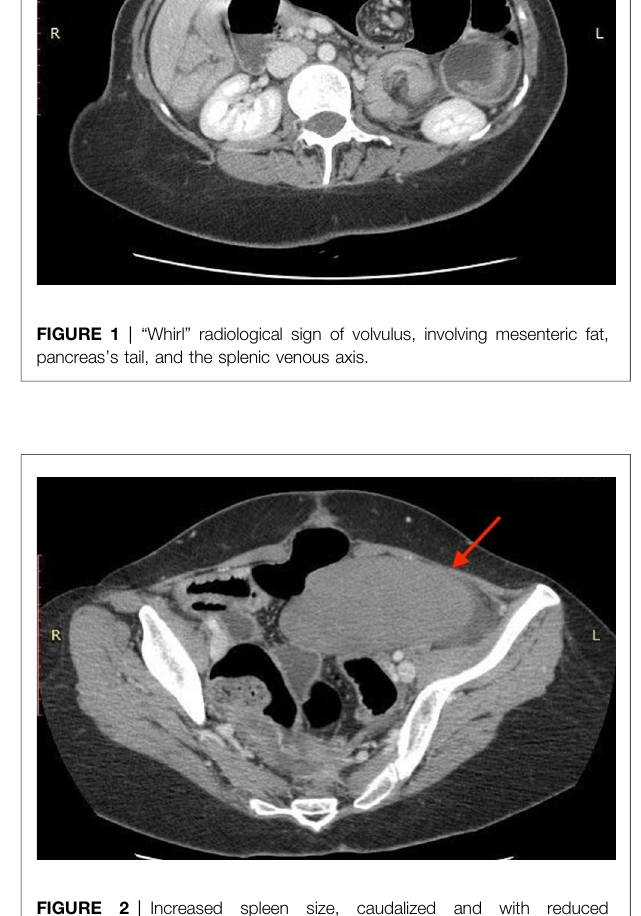
FIGURE 4 | Median sub-umbilical